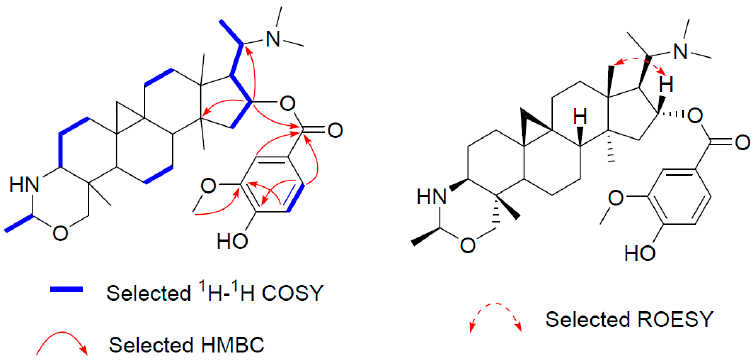
Figure 4. Key 2D correlations of 3 .